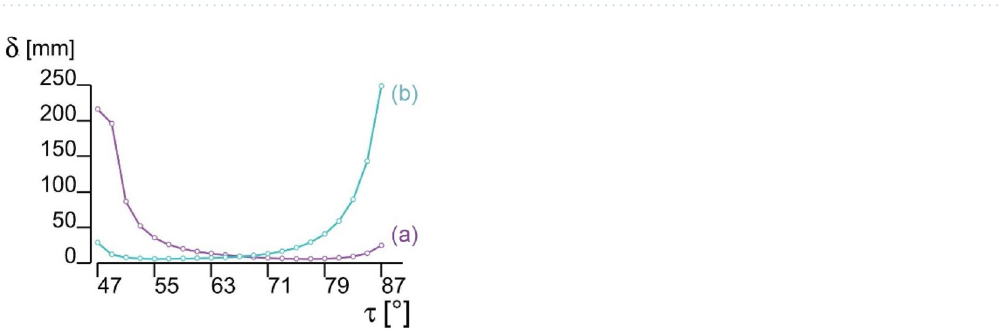
Figure 12. Sandwich floor with two-way corrugation. ( a ) Cells along transverse direction. ( b ) Cells along longitudinal direction.